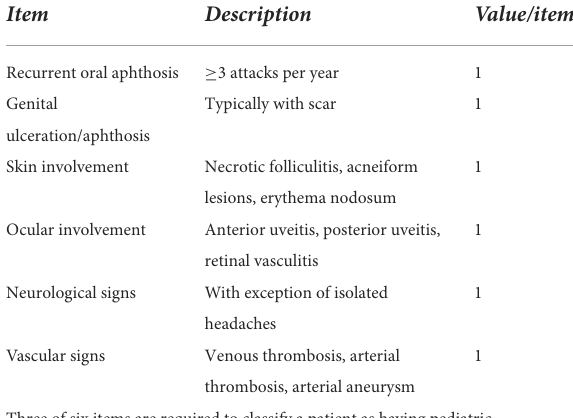
TABLE 3 Consensus classification of pediatric Behçet’s disease